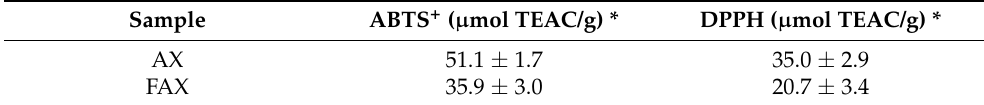
Table 3. Antioxidant activity of AX and